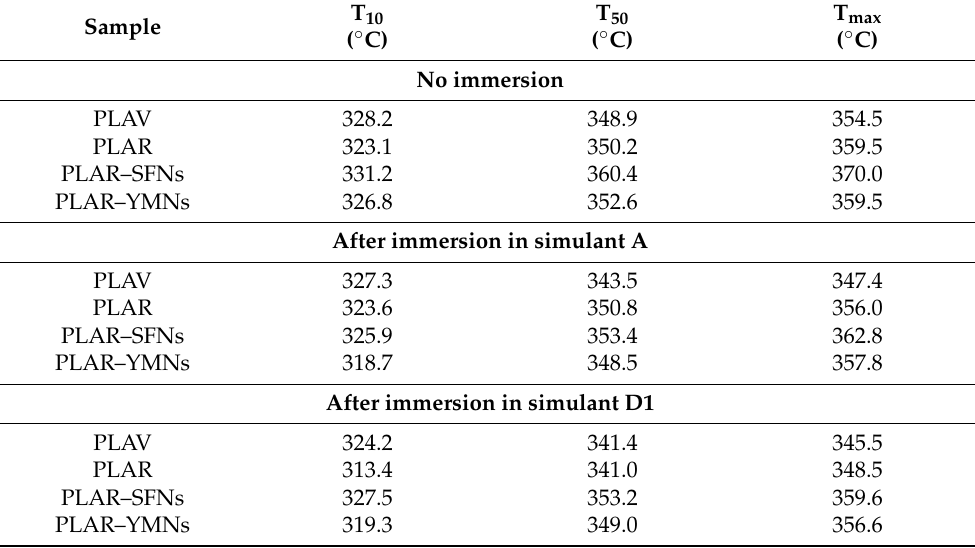
Table 3. TGA parameters of the samples before and after immersion in food